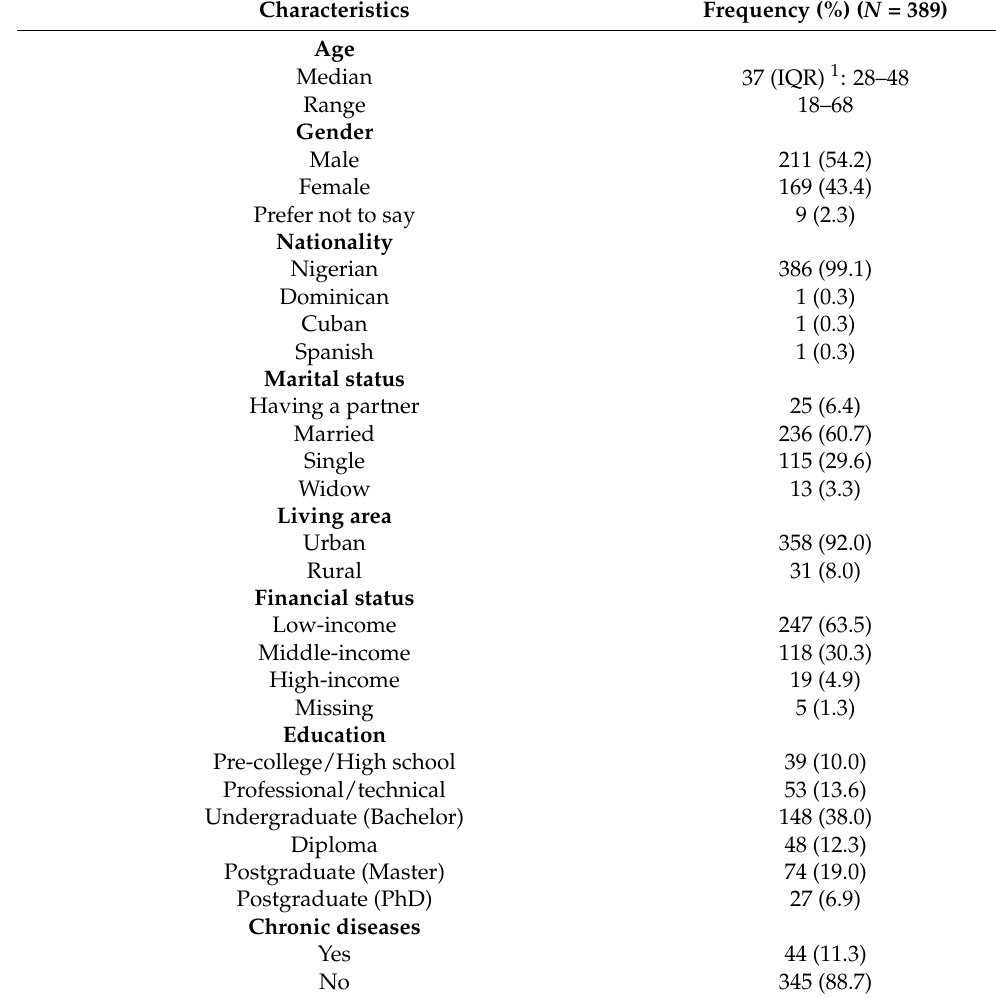
Table 1. Participants’ demographics and